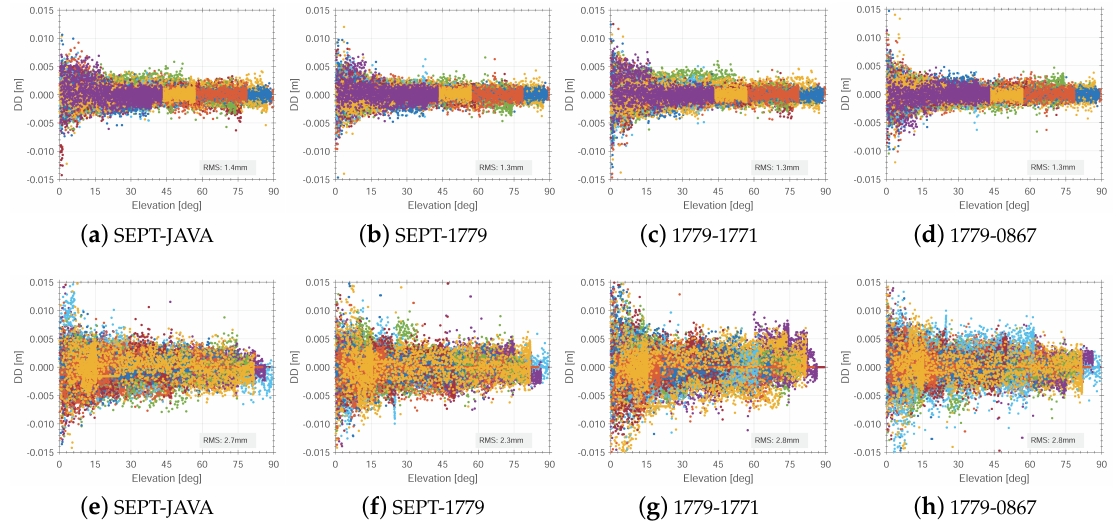
Figure 5. Double difference residuals of the carrier phase L1 C/A versus the elevation for selected receiver combinations on the frequency L1 and the signal C/A, system GPS ( a–d ), GLONASS ( e–h